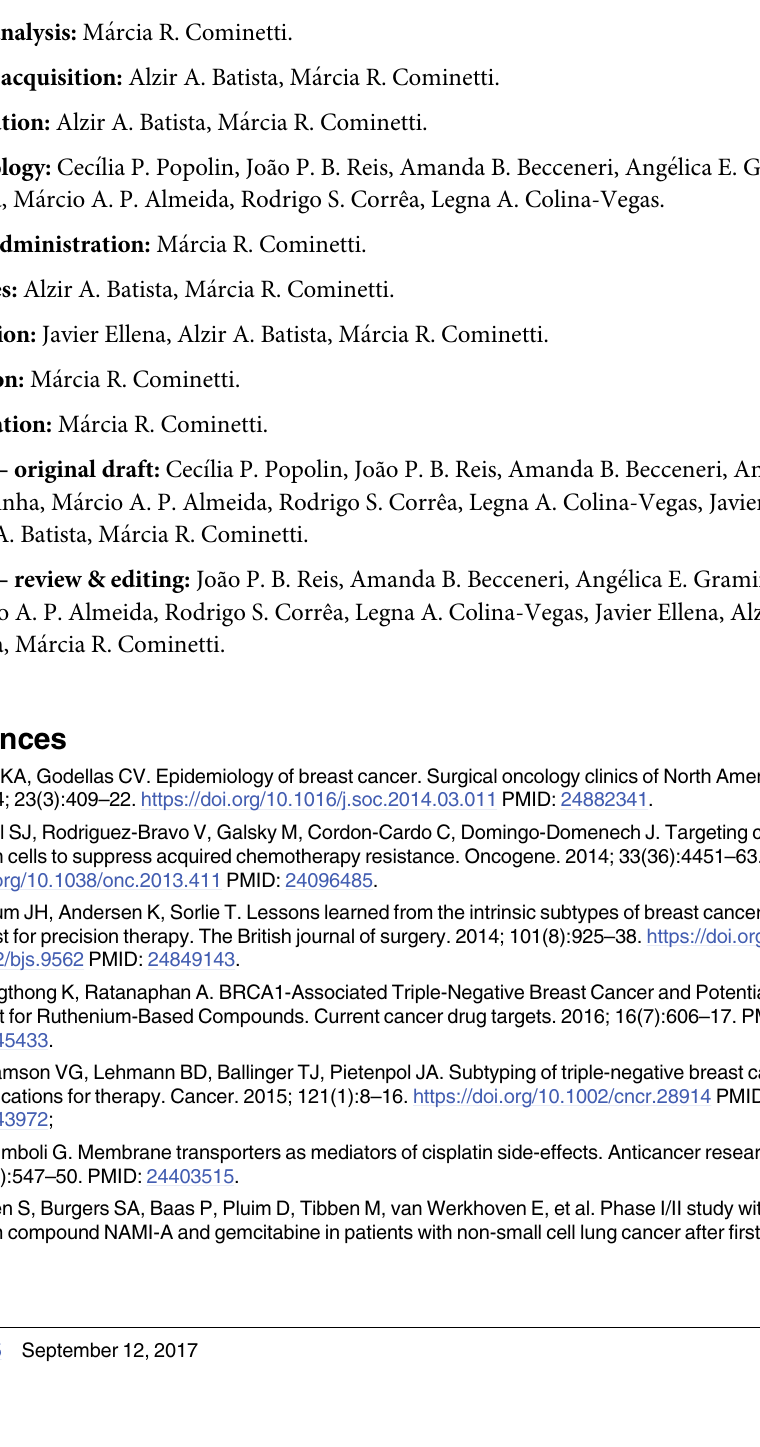
S4 Fig. Cellular morphology of MDA-MB-231, MCF-7 and MCF-10A cells, treated with complex